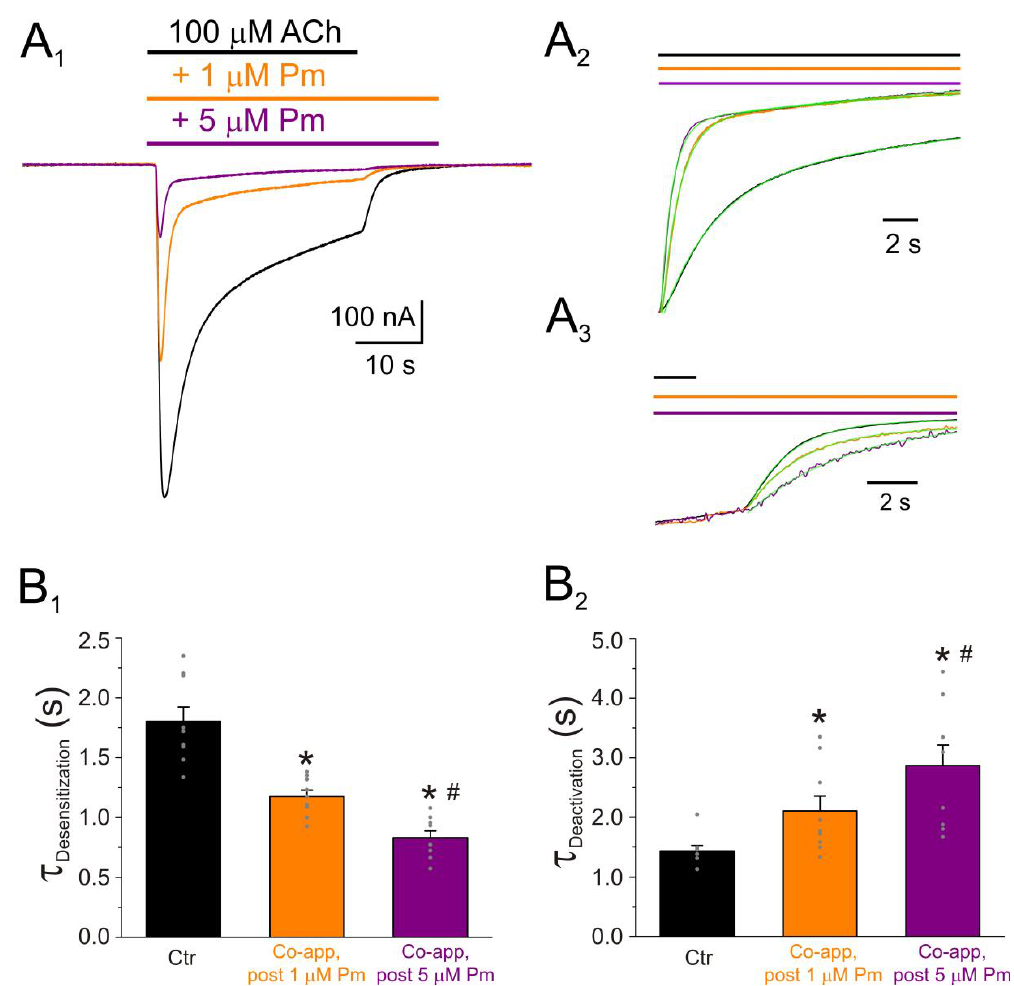
Fig.4 Figure 4. I ACh decay and deactivation kinetics depend on Pm concentration. ( A 1 , A 2 , A 3 ) Representative I ACh s elicited by 100 µ M ACh either alone (black recording) or together with 1 (orange) or 5 (purple) µ M Pm ( A 1 ). Pm superfusion remained 12 s after ACh washout (as indicated by the application bars). These recordings were normalized to either the same I p , to better compare their I ACh decay ( A 2 ), or the same I ss , to facilitate comparisons of deactivation kinetics ( A 3 ). ( B 1 , B 2 ) Column bar plots displaying the effect of 1 (orange) or 5 µ M (purple) Pm on the I ACh decay time-constant ( τ Desensitization ; ( B 1 )) and the deactivation kinetics ( τ Deactivation ; ( B 2 )), as compared to control I ACh s (in the presence of ACh alone; black). (*) indicates significant differences with the control group ( p < 0.05, paired t -test) and (#) indicates differences between 1 and 5 µ M Pm groups ( n = 9, N = 3; the same cells for all comparisons; p < 0.05, paired t -test). Notice that Pm accelerated the desensitization rate and slowed down the deactivation